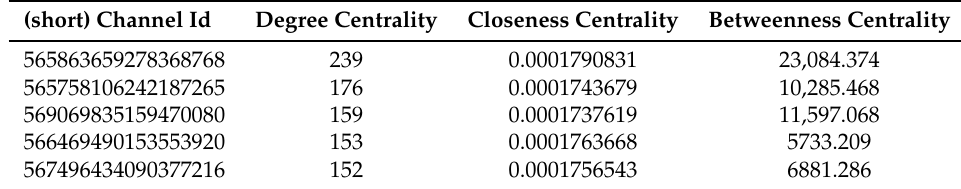
Table 5. Centrality measures for the highest degree nodes for the network in Figure 17.